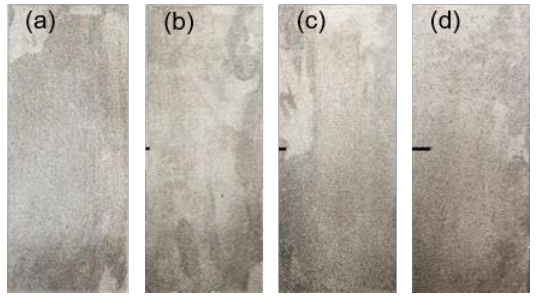
Figure 22. Comparison of γ f 1 and γ f 2 parameters: ( a ) α = 45 ◦ ; ( b ) α = 60 ◦ ; ( c ) α = 90 ◦ .